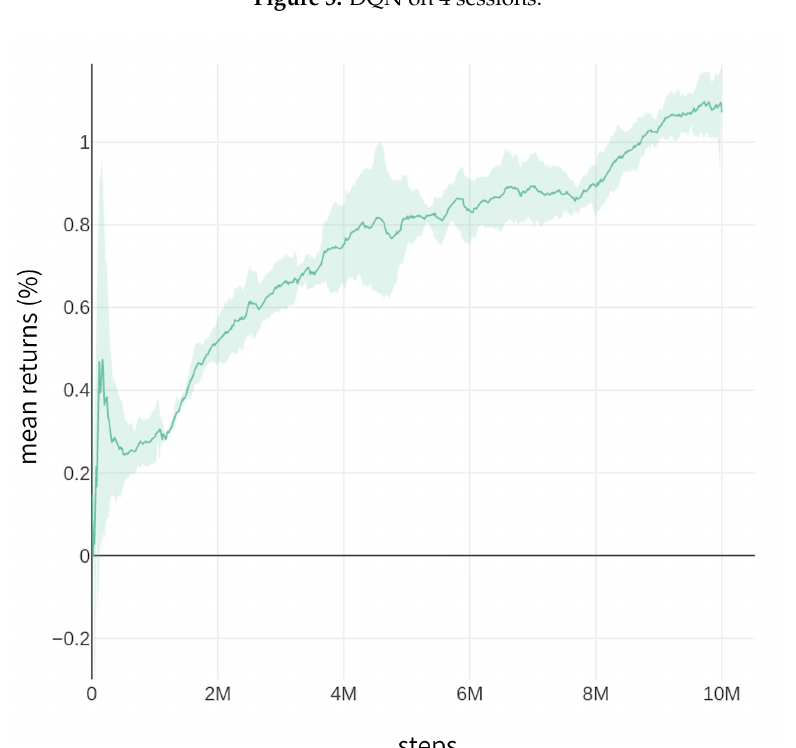
Figure 3. DQN on 4 sessions.